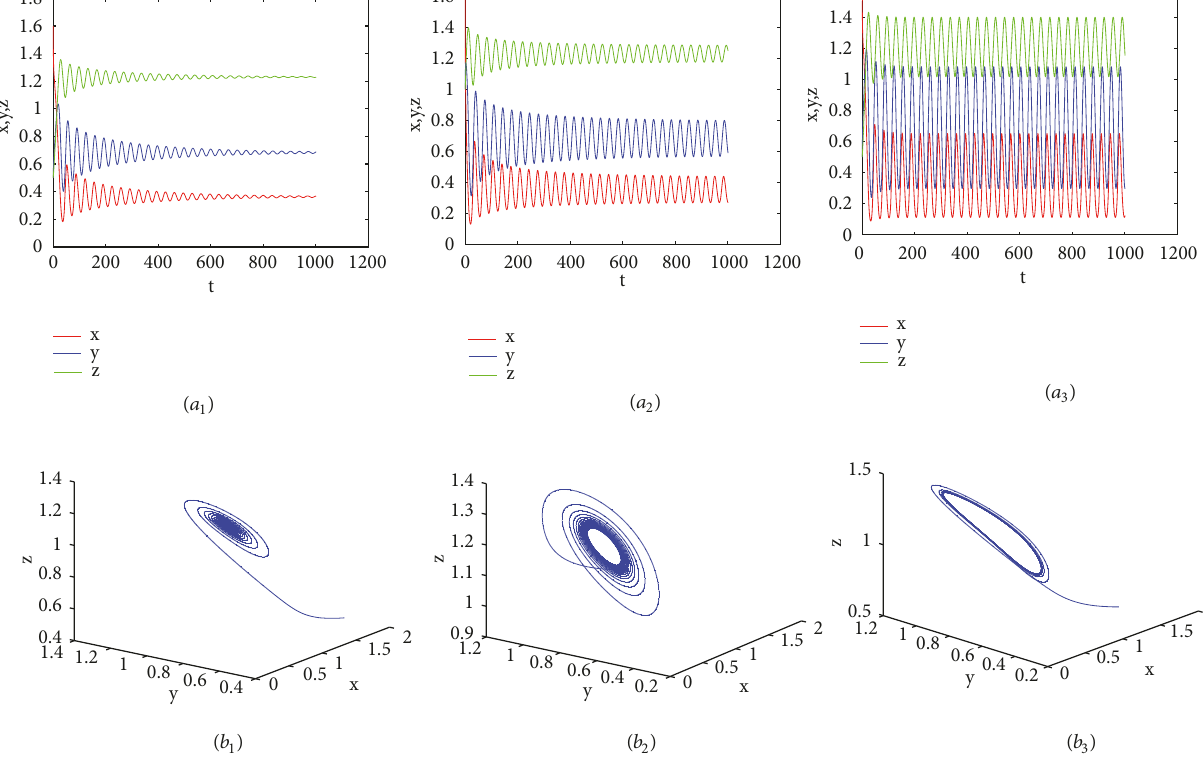
Figure 6: Time series plots and the three-dimensional space graphs of Experiment 4 with different parameters: (𝑎 1 ) and (𝑏 1 )𝑘 1 = 0.958 ; (𝑎 2 ) and (𝑏 2 )𝑘 1 = 0.989 ; (𝑎 3 ) and (𝑏 3 )𝑘 1 = 1.089